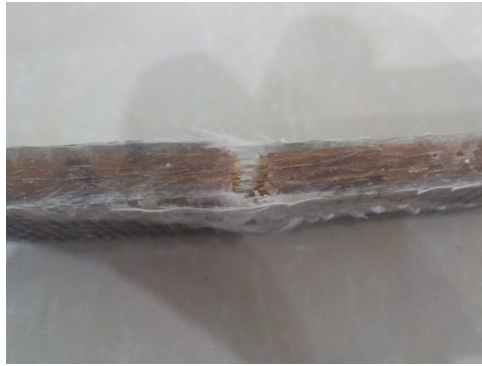
Figure 6: Fracture contour in tensile test specimen